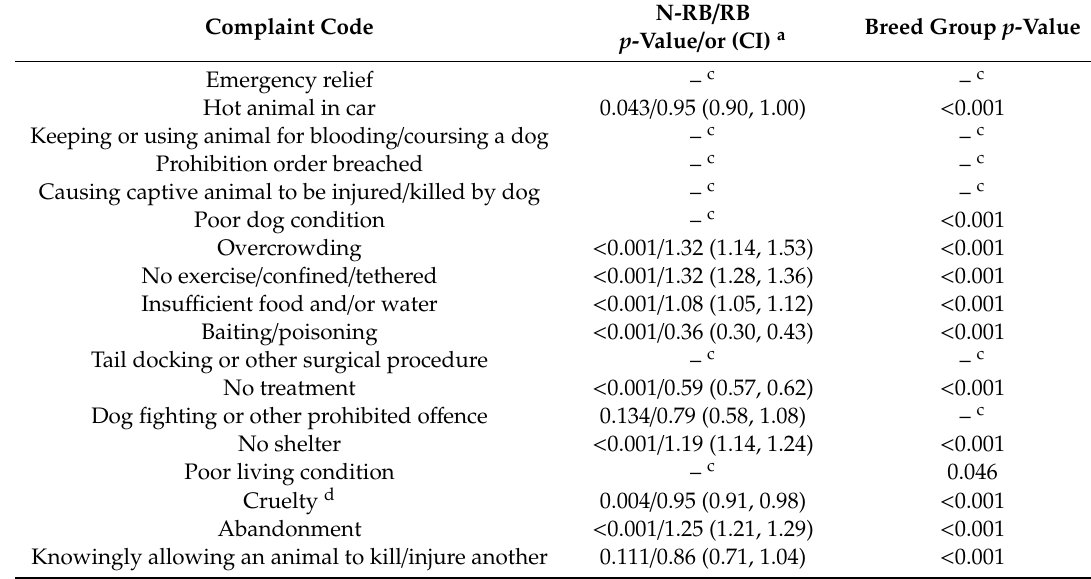
Table 3. Odds ratio of each variable in the logistic regression model of complaint codes. The outputs of these models were di ff erent complaint codes. The input variables were N-RB / RB and breed